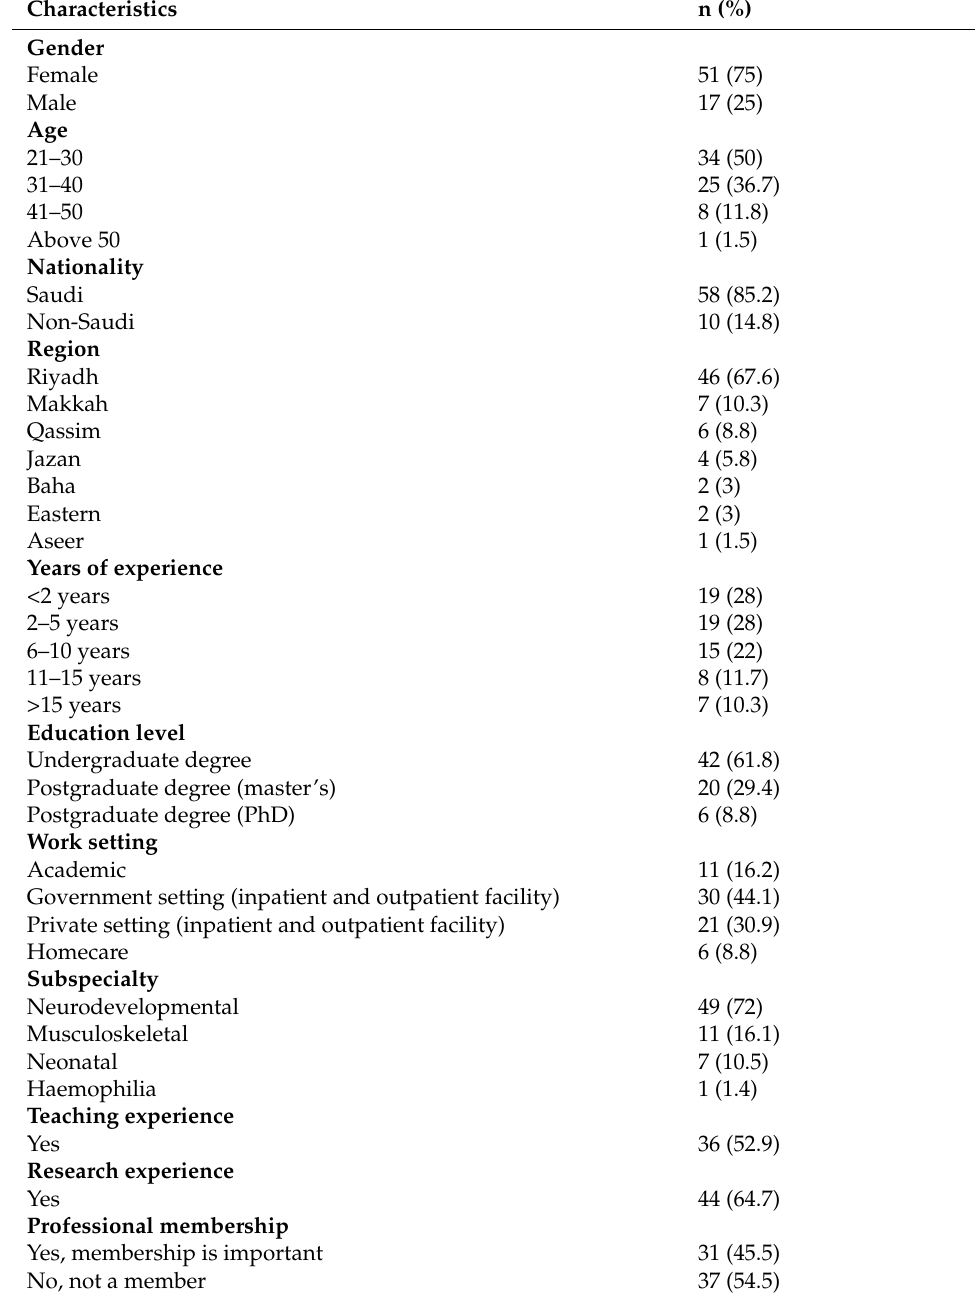
Table 1. Demographic characteristics of respondents (n =